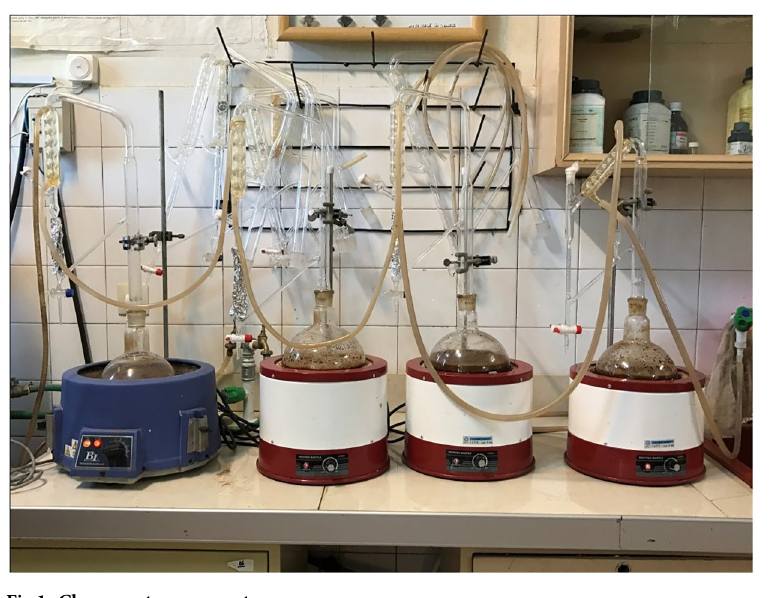
Fig 1. Clevenger type apparatus.